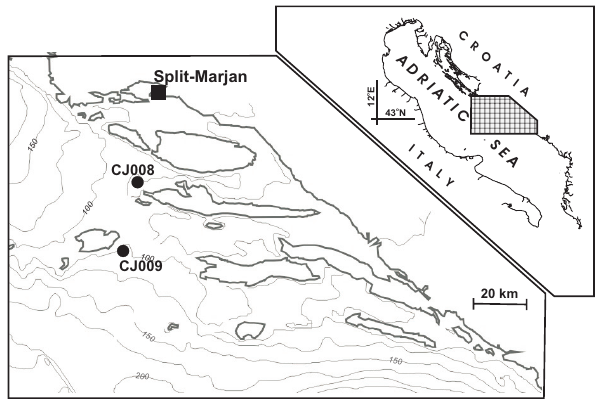
Fig. 1. Investigated area with positions of meteorological (Split- Marjan) and hydrographic (CJ008, CJ009)